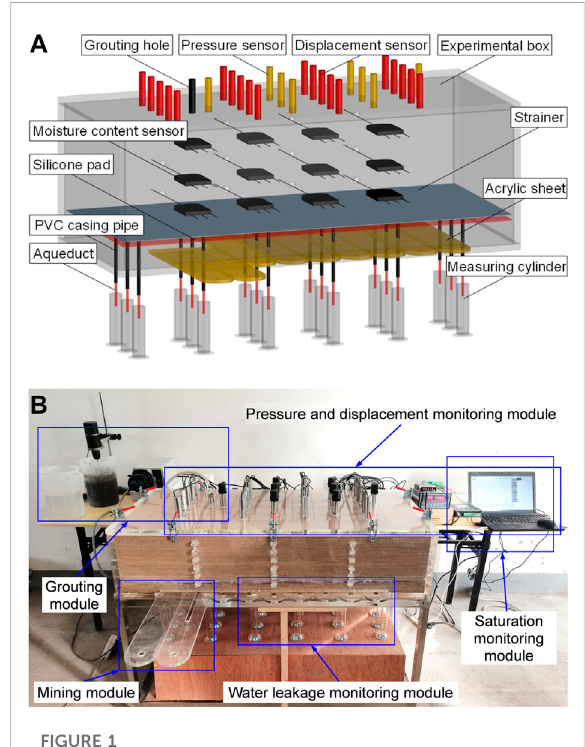
FIGURE 1 Three-dimensional visualization experimental system of “ diffusion-bleeding-seepage ” for overburden isolated grout injection. (A) Design diagram, (B) physical